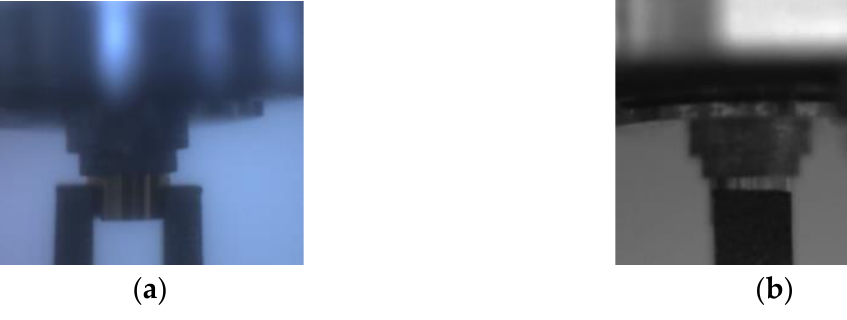
Figure 19. Parts ’ pose calibration of CCD 2. ( a ) Front view of the TMP — Component after assembly;